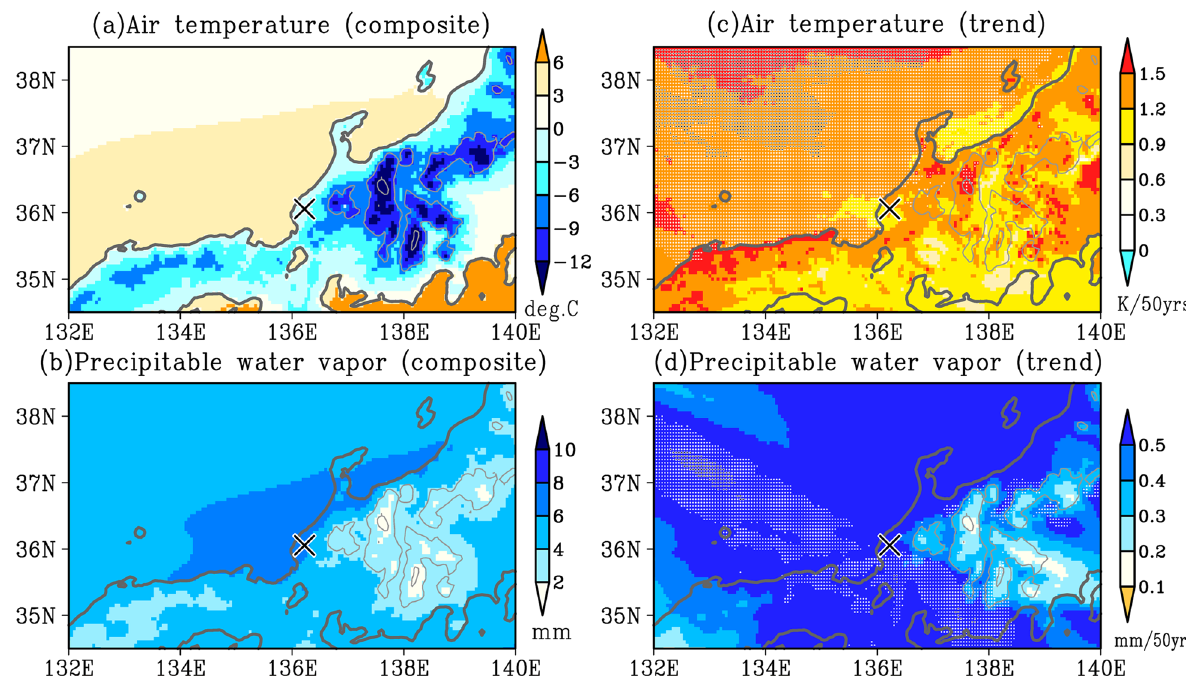
Fig. 13 Composites of surface air temperature and precipitable water vapor and their trends when Sx1d is calculated by DS5km. a Surface air temperature and b its trend; c precipitable water vapor and d its trend. White and black dots show statistically significant grids with 90 and 95% confidence levels,